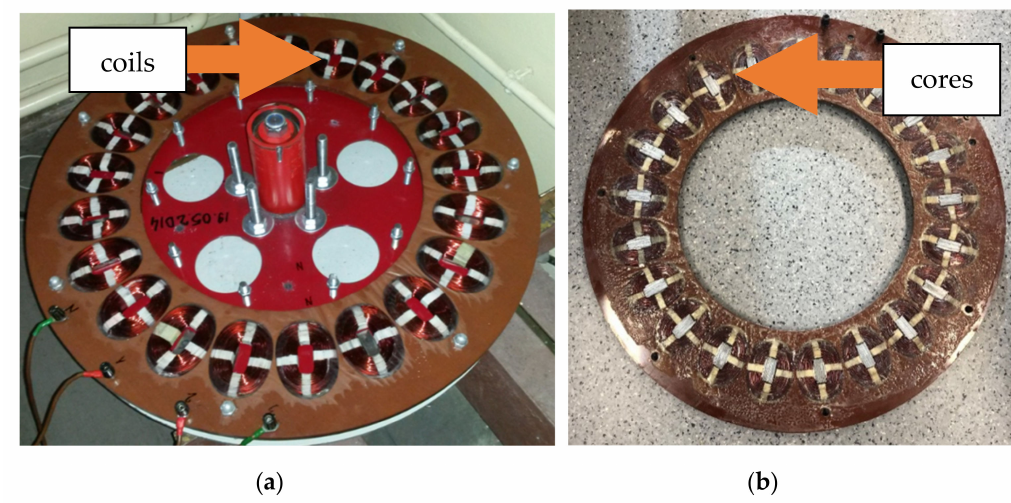
Figure 5. Stator discs; ( a ) coreless; ( b ) with cores.